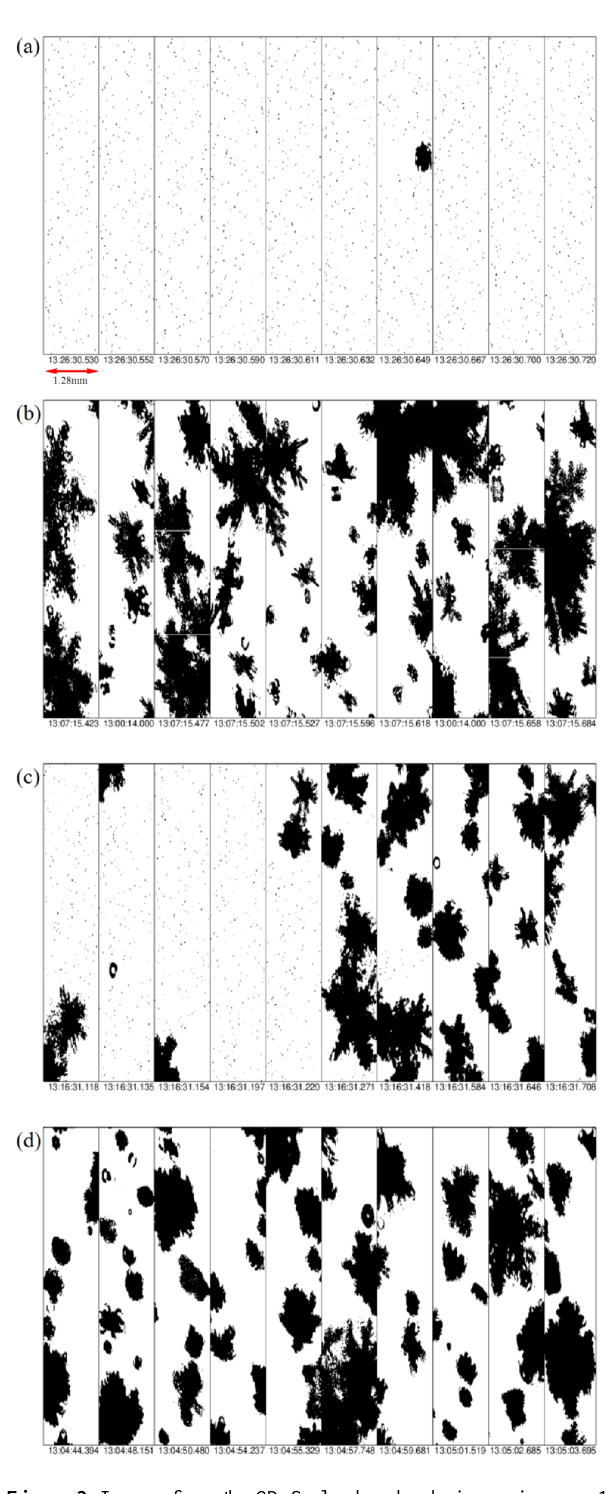
Figure 3. Images from the 2D-S cloud probe during spring case 1 from (a) a cloud top region during A1, (b) 500m below cloud top during A2, (c) region of swift transitions between ice and liquid, and (d) a precipitation region below cloud